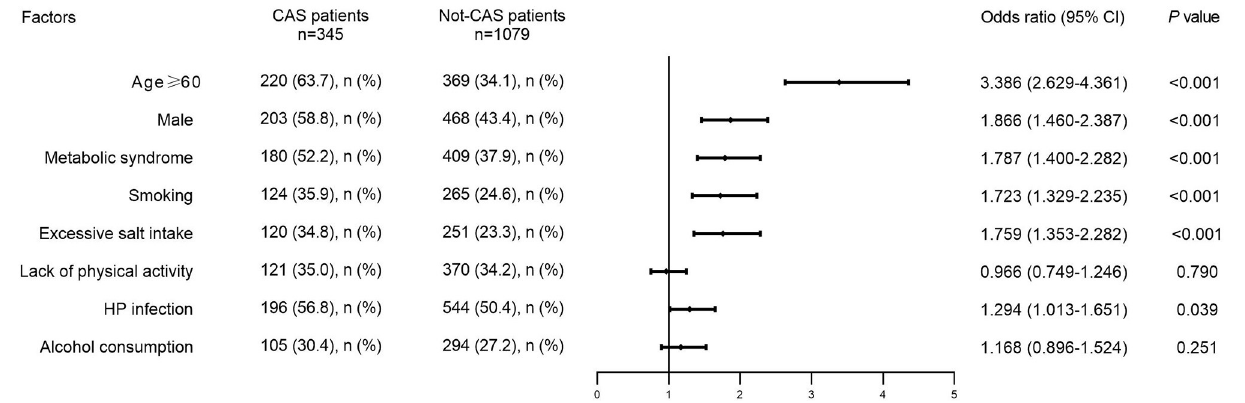
the HP-positive and HP-negative groups, respectively ( Table 2